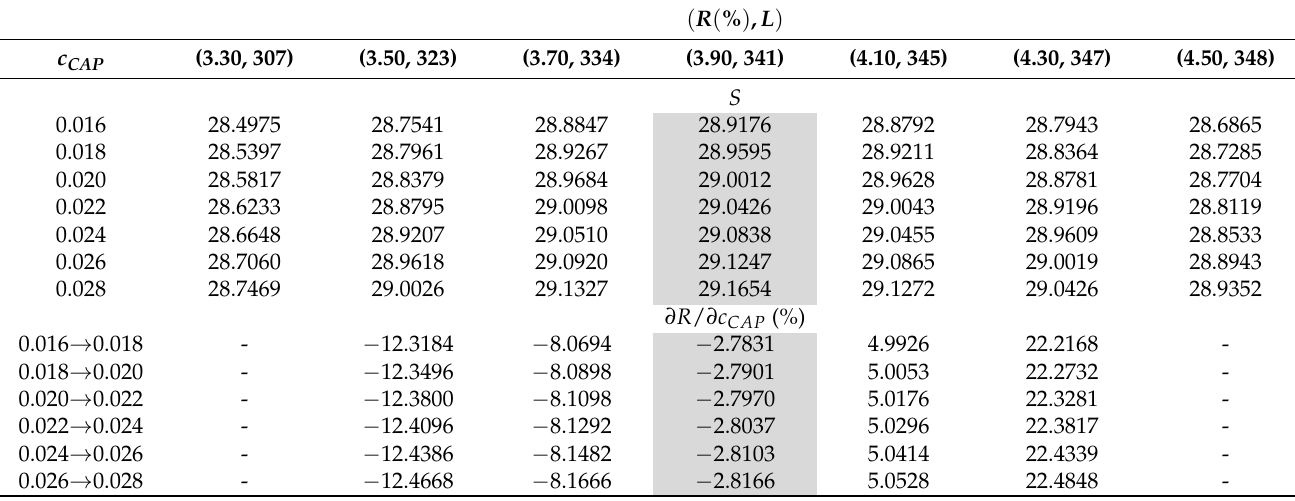
Table 2. Responsiveness of the optimal guaranteed rate to c CAP